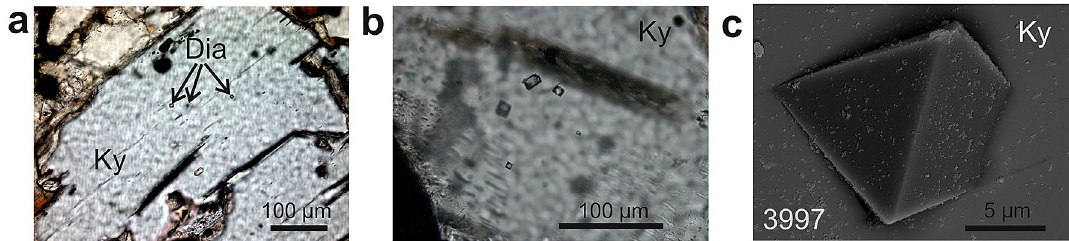
Figure 1. Distribution, mode of occurrence, morphology and surface of microdiamonds, rock A. ( a , b ) Photomicrographs showing diamond distribution within kyanite. ( c ) Perfect crystal shape, smooth surface and sharp edges and corners of diamond enclosed in kyanite (SEM). Four-digit number refers to FIB-TEM sample numbers in Supplementary Table S2.